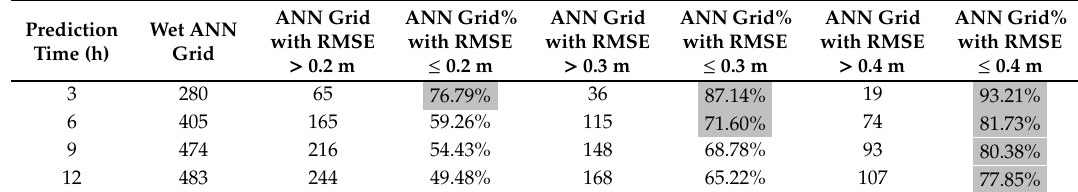
Note: highlighted in gray are the percentages larger than